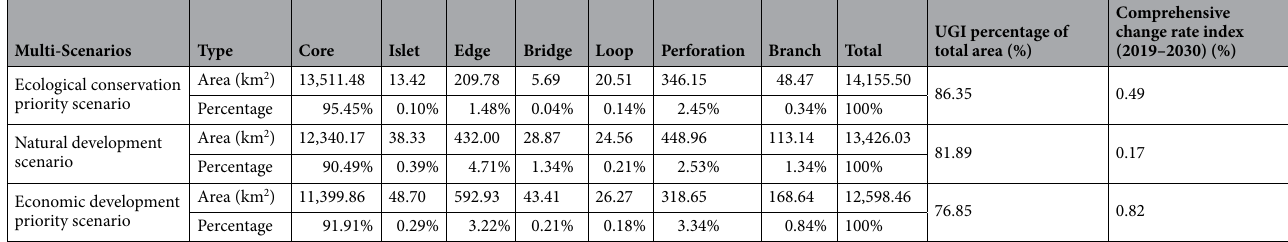
Table 2. The area and rate of change of UGI in Beijing in